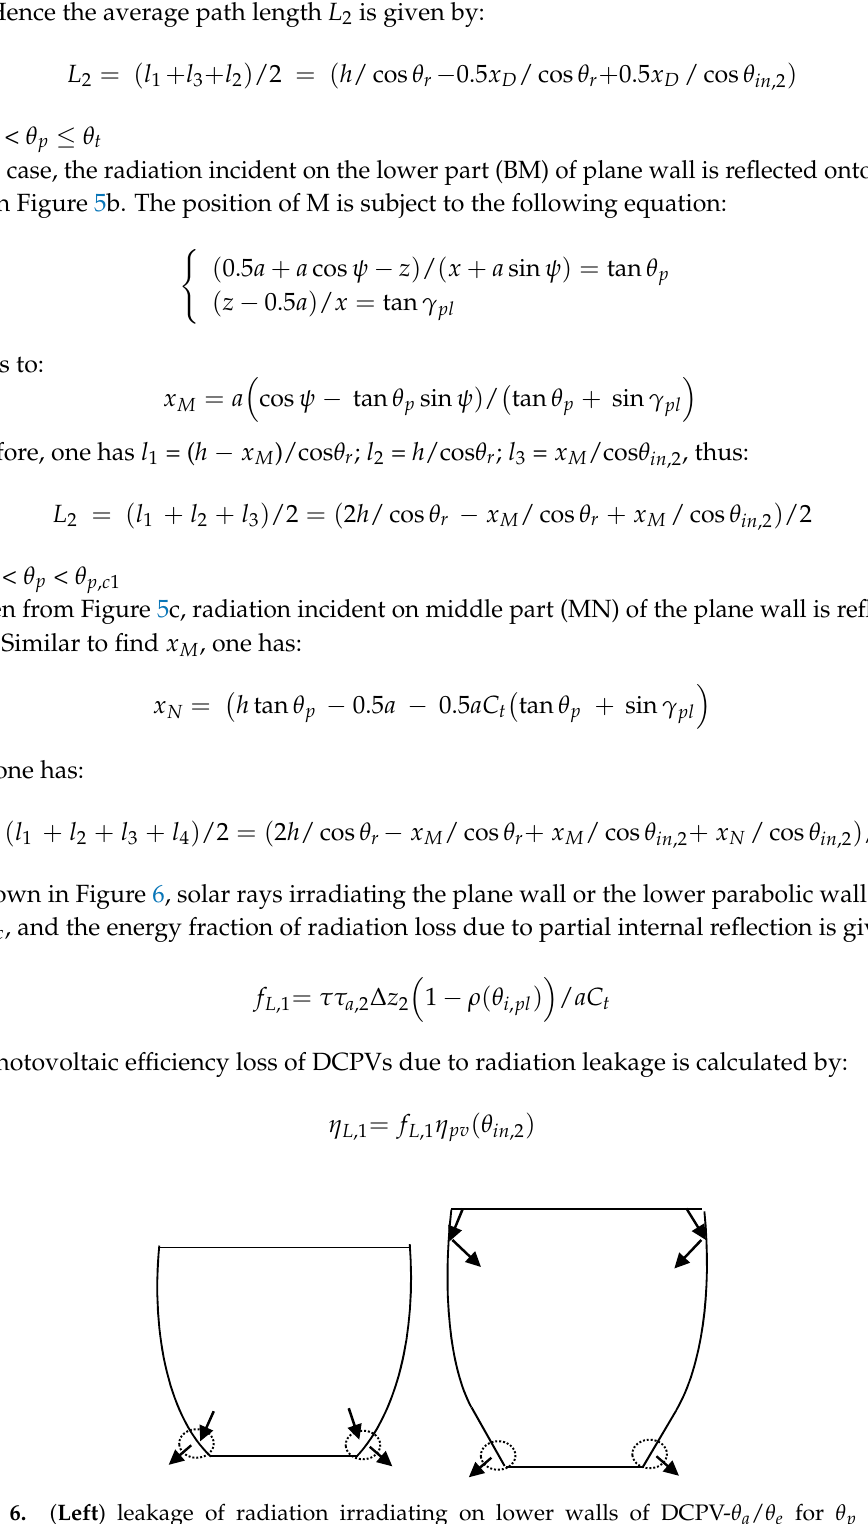
Figure 6. ( Left ) leakage of radiation irradiating on lower walls of DCPV- θ a / θ e for θ p ≤ θ a ; Figure 6 . ( Left ) leakage of radiation irradiating on lower walls of DCPV- ( Right ) leakage of radiation irradiating on upper parabolic walls for θ p > θ a leakage of radiation irradiating on upper parabolic walls for